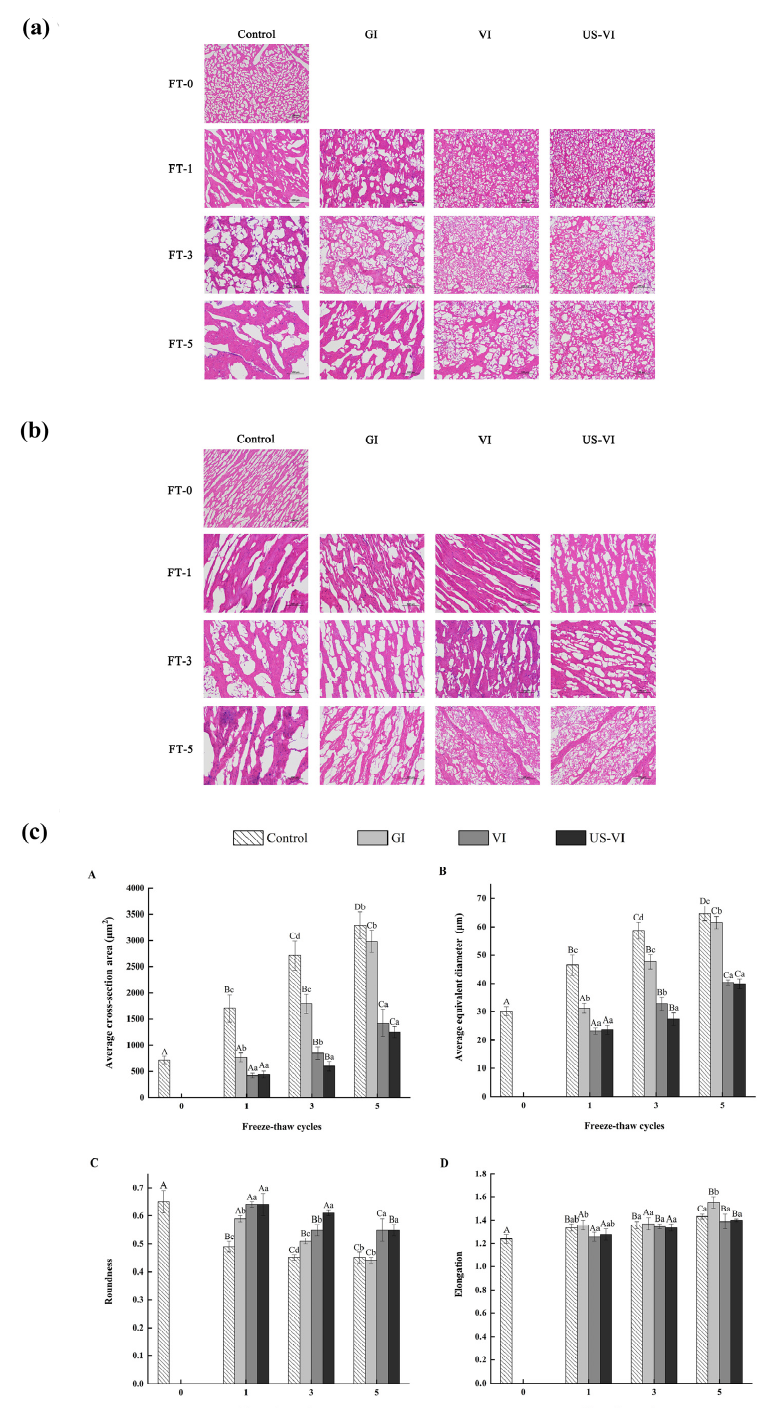
Figure 4. The observation and analysis of the ice crystal morphology of the scallop adductor muscle induced by freeze–thaw cycles (magnification: 200 × ). ( a ) Transverse section; ( b ) longitudinal section; ( c ) analysis of the ice crystals morphology (( A ) average cross-section area; ( B ) average equivalent diameter; ( C ) roundness; ( D ) elongation). FT-0, 1, 3, and 5: number of freeze–thaw cycles. “A–D” indicated the difference in different number of FTCs ( p < 0.05). “a–d” indicated the difference in samples with different pretreatment methods ( p <